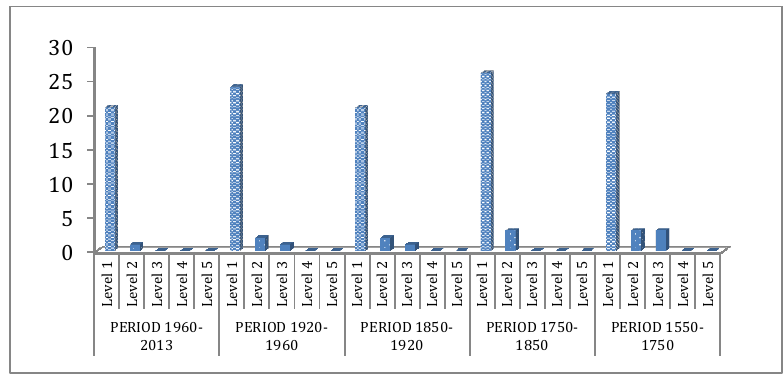
Figure 7 . Quality of argumentation in team A by historical